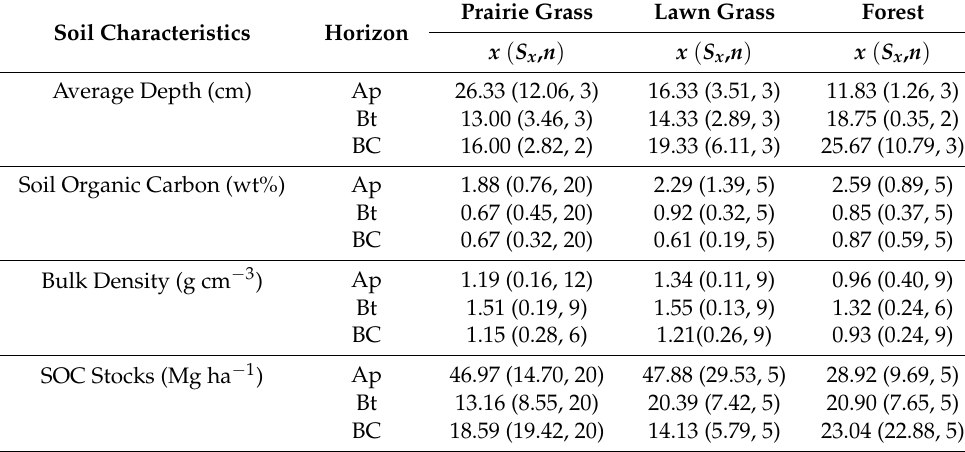
Table 2. Soil organic carbon (SOC, wt%), bulk density (Bd g cm − 3 ), and SOC stock (Mg ha − 1 ) sample mean ( x ), standard deviation ( S x ), and sample size ( n ) for the pits and auger holes of the soil horizon. Prairie Soil Characteristics Horizon